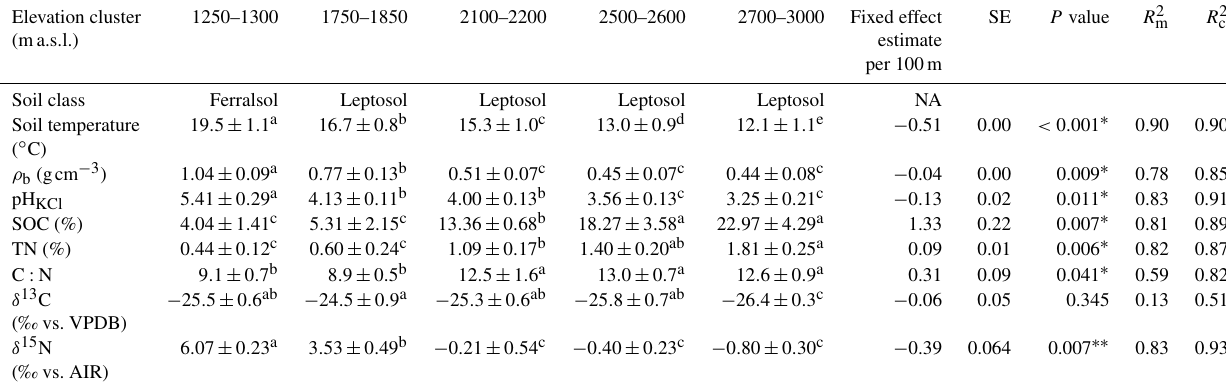
Table 1. Physicochemical soil properties (0–10cm) of the elevation gradient on the east-facing slope of the Rwenzori Mountains National Park (1750–3000ma.s.l.) and the premontane Kibale Forest National Park (1250–1300ma.s.l.). Indicated are the mean values plus/minus the standard deviations of the average annual soil temperature at 5cm depth, bulk density ( ρ b ), pH in KCl solution (pH KCl ), soil organic carbon (SOC) content, total nitrogen (TN) content, carbon-to-nitrogen ratio (C : N), δ 13 C values, and δ 15 N values. The elevation trend from the linear mixed effect regression model estimate per 100m of elevation increase is also indicated with the standard error (SE), P value, marginal R 2 ( R 2 m ), and conditional R 2 ( R 2 c